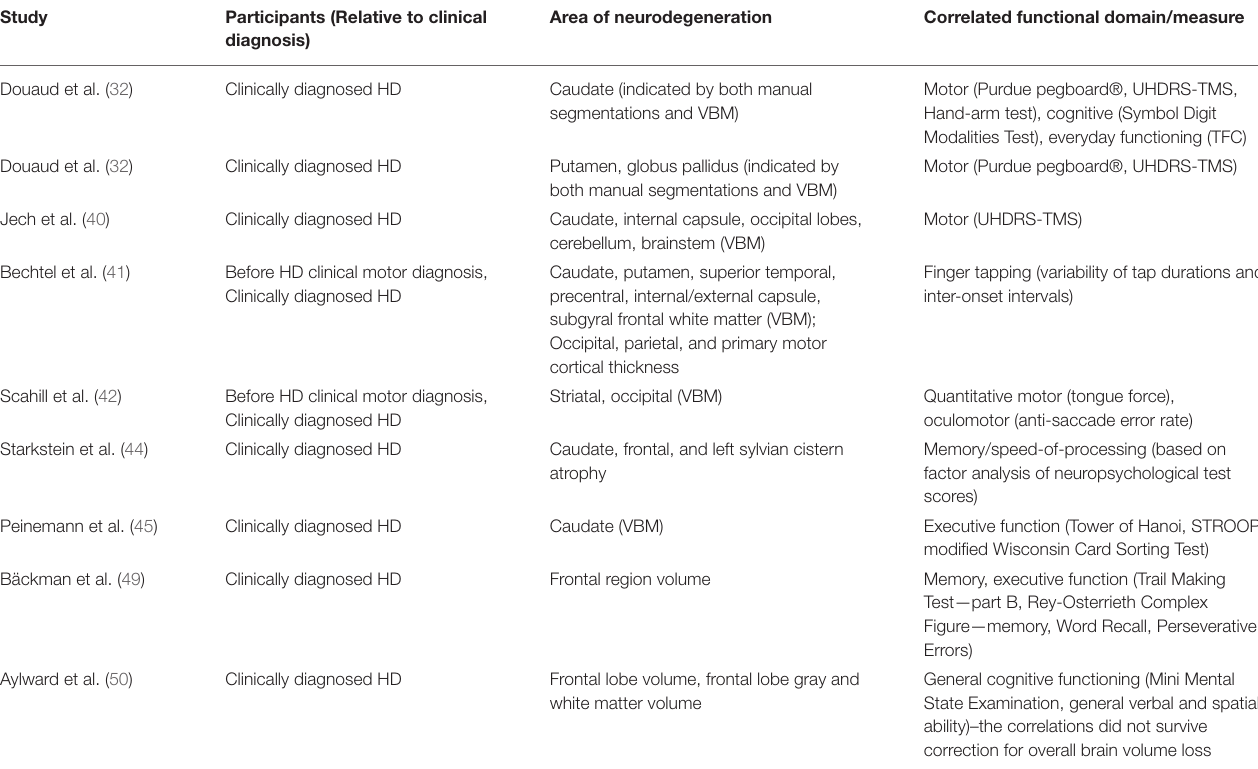
TABLE 2 | Areas of neurodegeneration and their correlations with functional domains/measures.